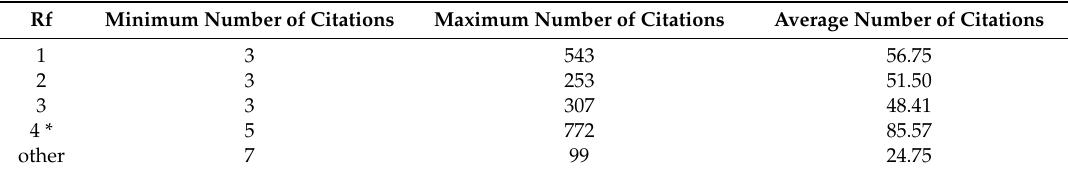
Table 2. Analysis of the citations trend by RF.